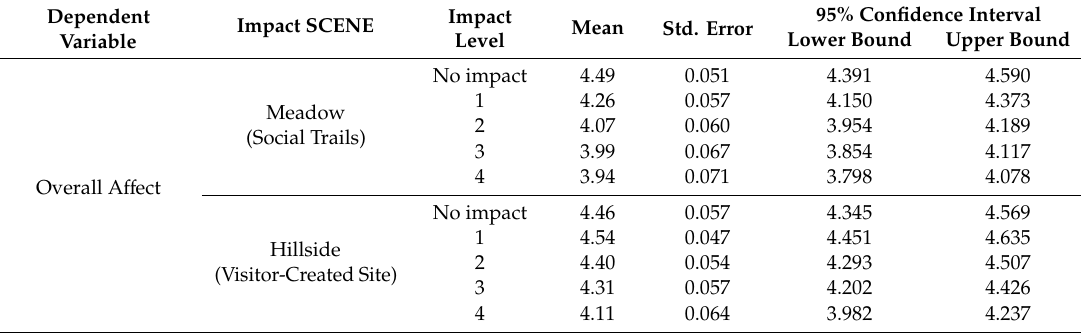
Figure 3. ( a ) Graphical display of relationship between impact scene (meadow with social trails and hillside with visitor-created site levels), impact level, and overall a ff ect. 1 Measured on a scale from 1 “very frowny face” to 5 “very smiley face.” * Denotes that means from di ff erent scenes with same impact level are significantly di ff erent ( p < 0.05) using Bonferonni post-hoc comparisons. ( b ) Graphical display of relationship between impact scene (meadow with social trails and hillside with visitor-created site levels), impact level, and activation. 1 Measured on a scale from 0 “not at all” to 100 “very much so.” * Denotes that means from di ff erent scenes with same impacr level are significantly di ff erent ( p < 0.05) using Bonferonni post-hoc comparisons. ( c ) Graphical display of relationship between scene (meadow with social trails and hillside with visitor-created site levels), impacts level, and positive-negative a ff ect. 1 Measured on a scale from 0 “not at all” to 100 “very much so.” * Denotes that means from di ff erent scenes with same impact level are significantly di ff erent ( p < 0.05) using Bonferonni post-hoc comparisons. Table 2. Comparisons for overall a ff ect, activation level, and positive–negative